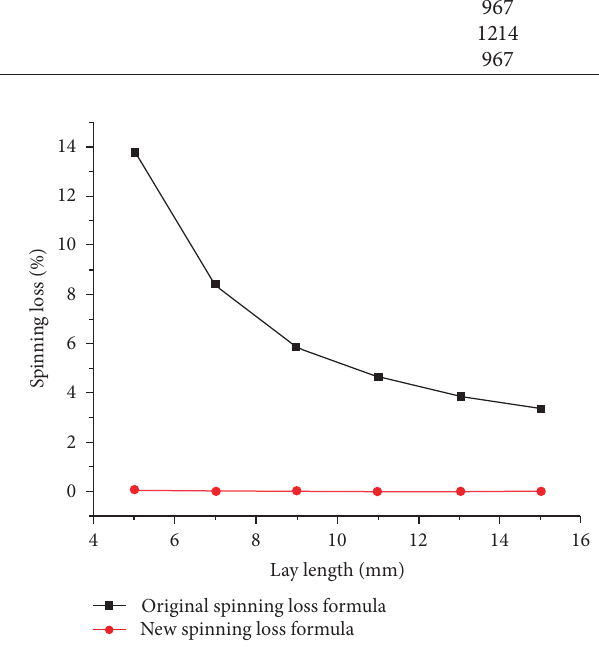
Figure 8: The spinning loss of steel cords varies with the lay length.